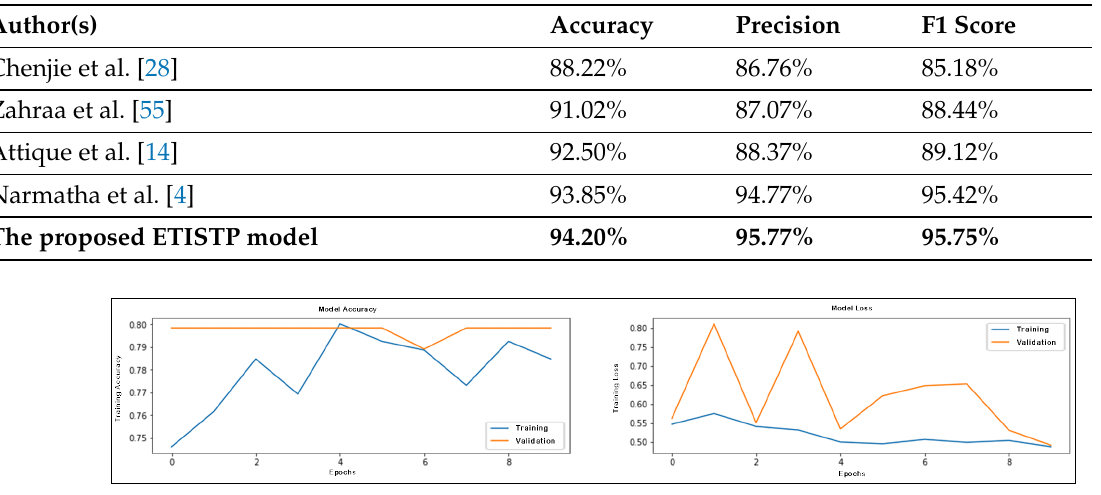
Figure 13. T1: Model accuracy and loss for 10 epochs.